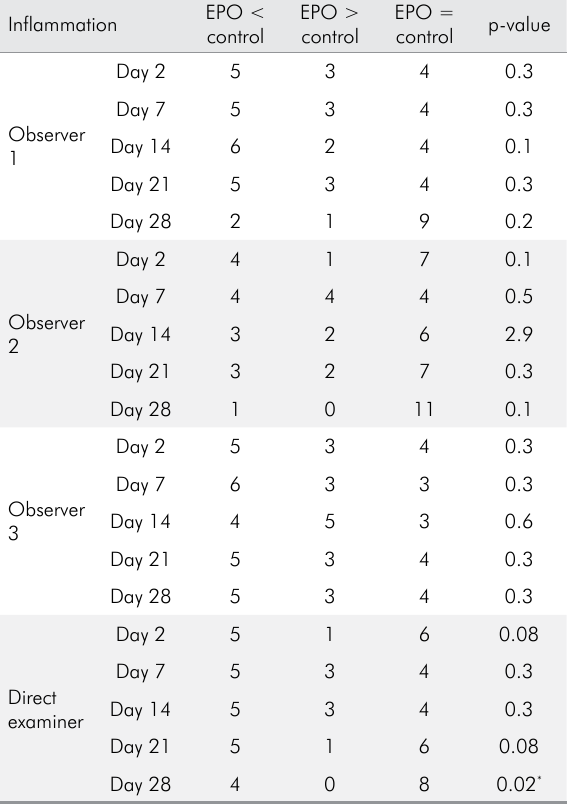
Table 3. The amount of inflammation based on the photography and direct